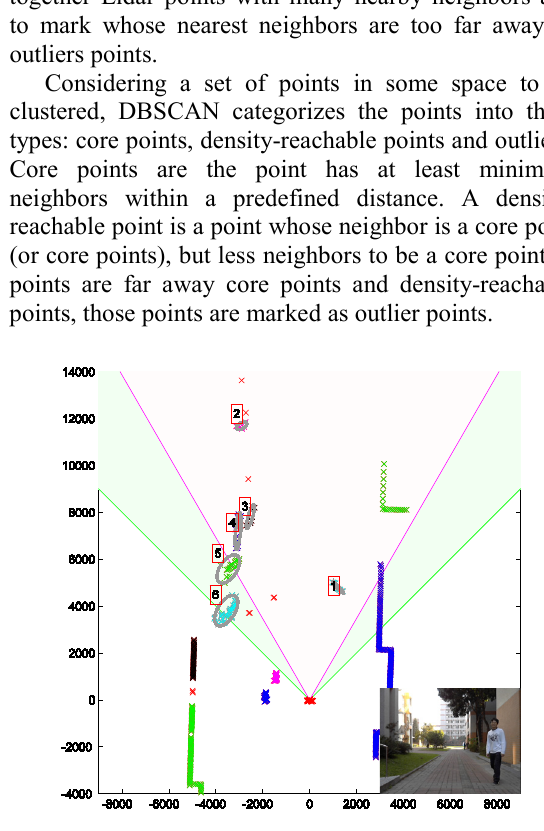
Fig. 3. The results of candidate selection are marked by gray circles. The noise points are colored with